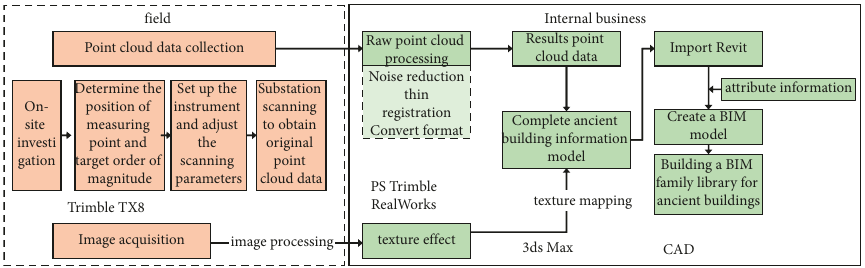
Figure 4: Flowchart of reconstruction of the ancient building